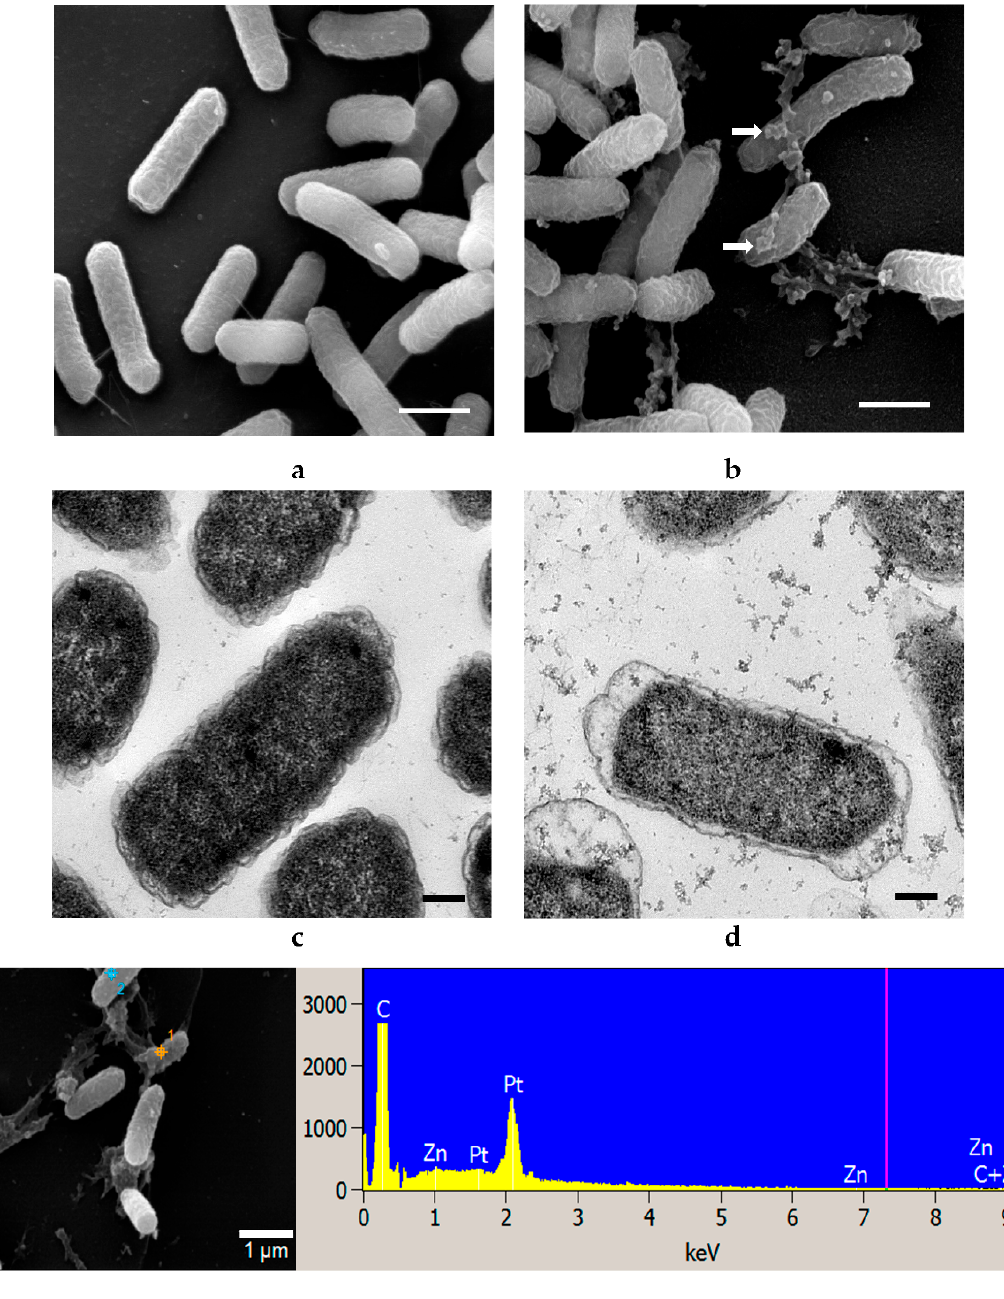
Figure 4. SEM ( a , b ) and TEM ( c , d ) images of E. coli untreated with ZnO NPs ( a , c ) and treated with 20 mM ZnO NPs ( b , d ). White arrows indicated clusters of ZnO NPs. SEM-EDS analysis shows ZnO presence on cell surfaces ( e ). SEM scale bar ( a , b ) = 1 μ m, TEM scale bar ( c , d ) = 0.2 μ m.